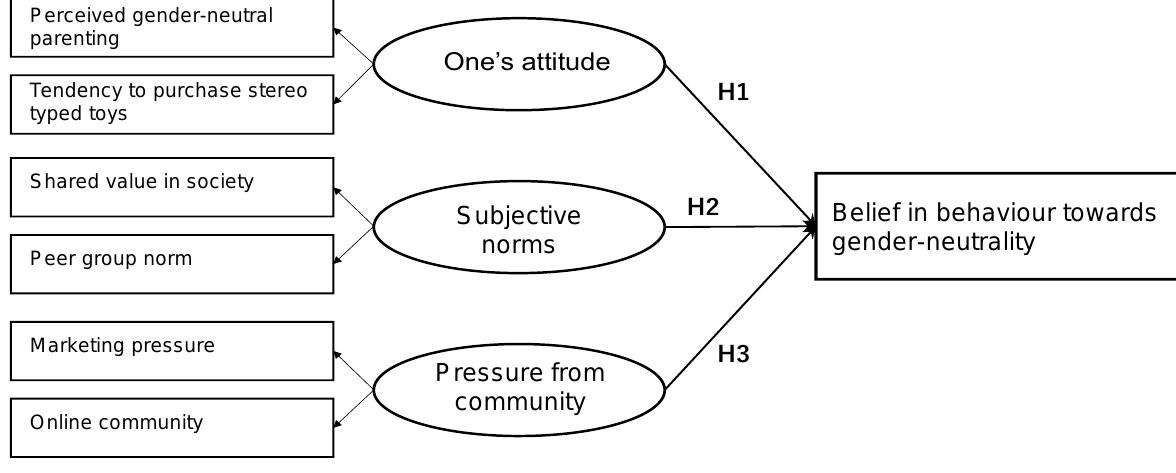
Figure 1. Conceptual model for the